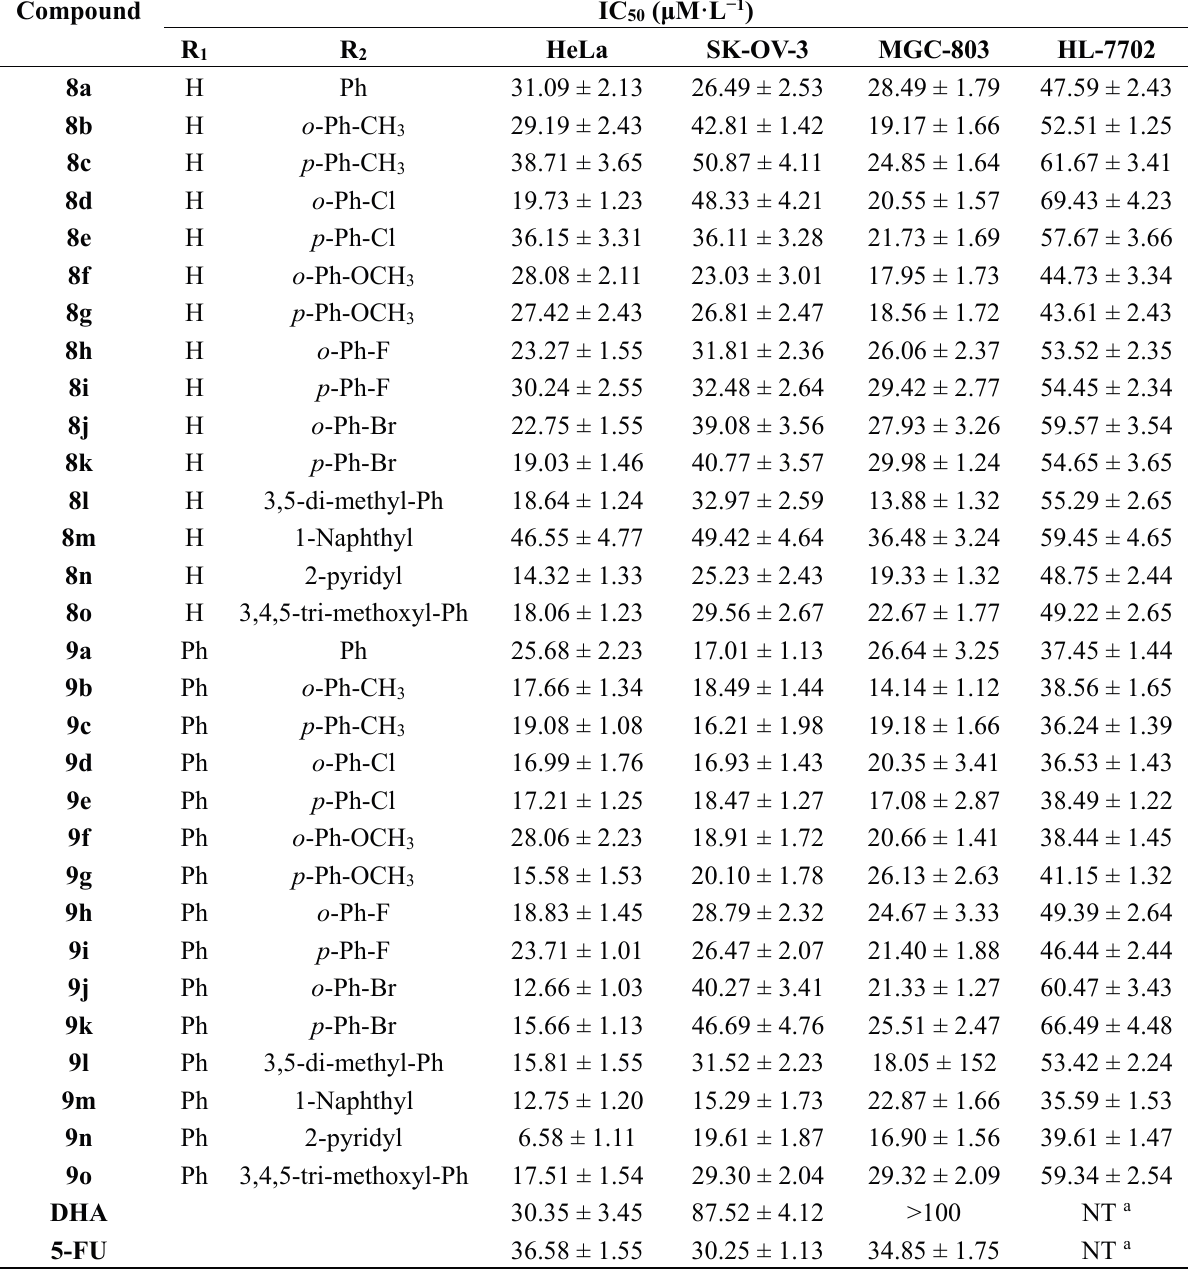
Table 1. Effect of compounds 8a – 8o and 9a – 9o against cell viability of different cell lines.